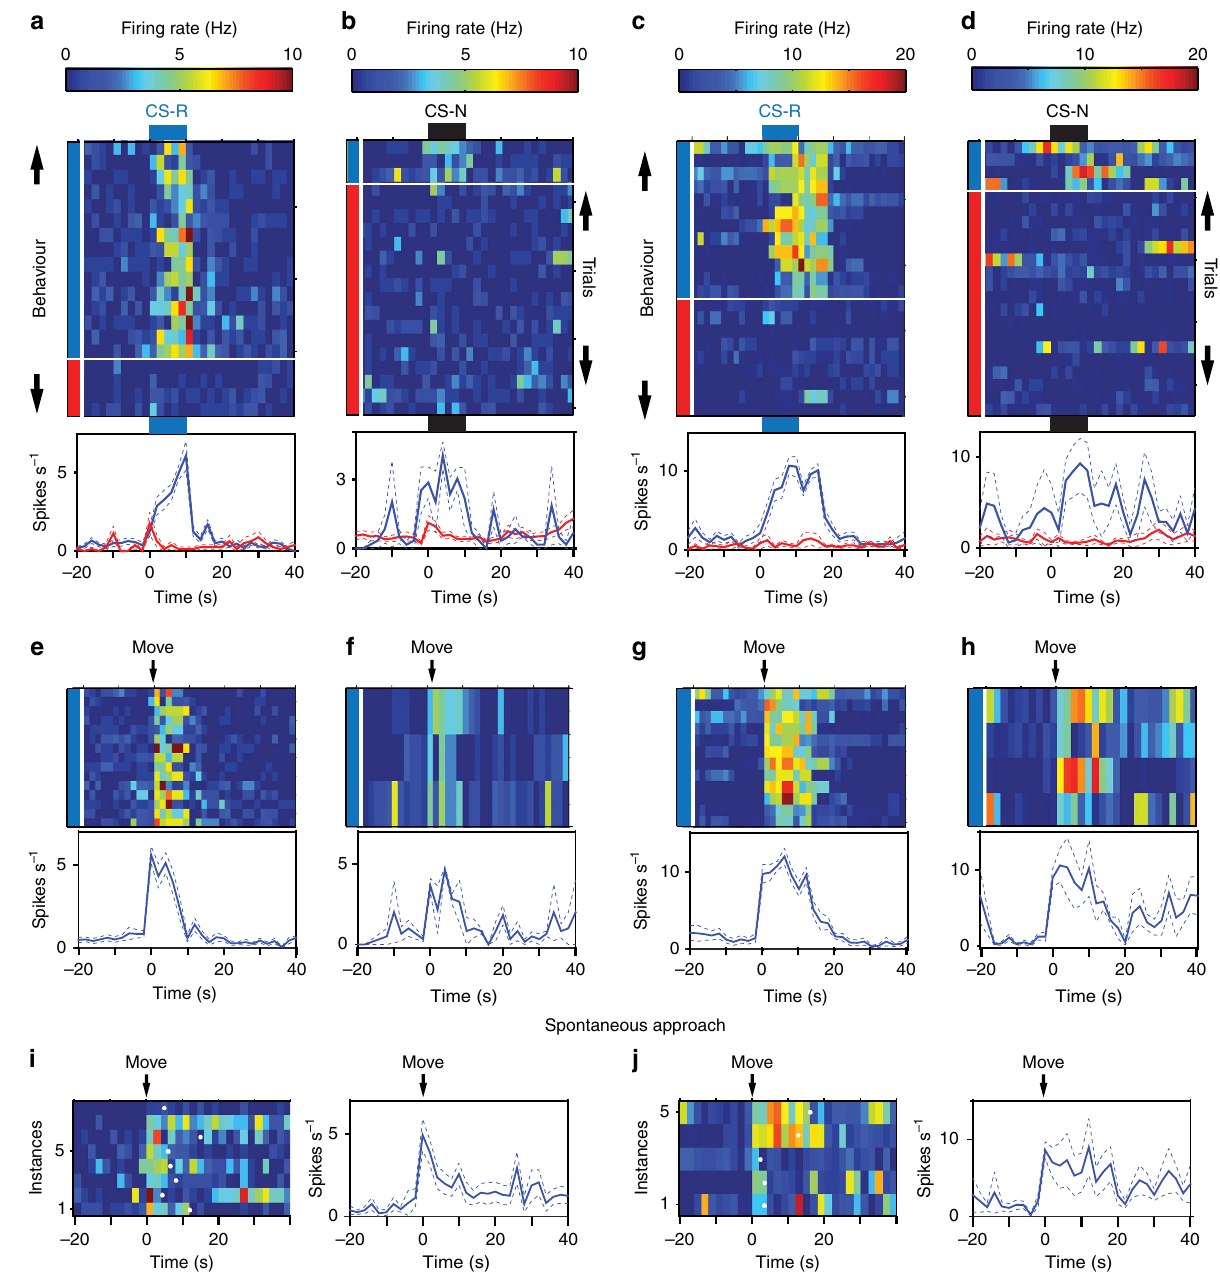
Figure 2 | Representative examples of R-cells. The left - ( a , b , e , f , i ) and right-most ( c , d , g , h , j ) panels show two different cells. Responses elicited by CS-R ( a , c ) or CS-N ( b , d ). For each cell and CS combination, activity is depicted as a colour-coded raster (top) and peri-stimulus histogram of neuronal discharges (bottom; solid and dashed lines are averages and s.e.m., respectively). Trials are grouped by behaviour (blue, approach of water-port; red, no approach; bar on left of rasters). Rasters and peri-stimulus histograms in ( e – h ) depict the activity of the same cells as in ( a – d ) but aligned to onset of water-port approach instead of CS onset. Trials in ( e – h ) were obtained with the CS-R and CS-N, respectively. ( i , j ) Rasters and histograms show activity of the cells when rats spontaneously initiated approach of the water-port in the absence of CS. White dots in rasters shown in ( i , j ) indicate time when rats left the water-port. Approach initiation time was defined as the time point when rats initiate their final approach movement with straight trajectory and no pause towards water-port (see details in Methods section). Departure from water-port was defined as time when rats head moved away from the water-port for at least